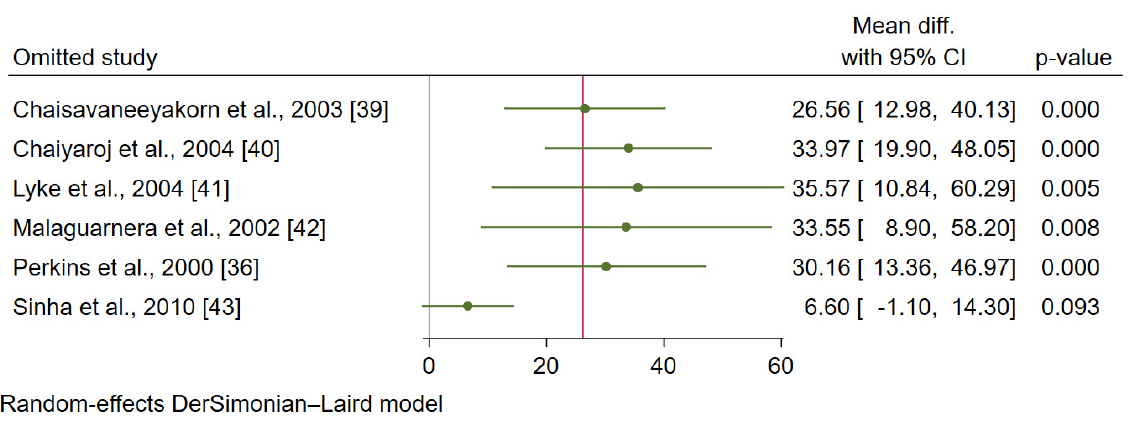
Figure 9. The results of the leave-one-out meta-analysis of the difference in the mean IL-12 levels (pg/mL) between patients with uncomplicated malaria and healthy controls [36,39–43]. (pg/mL) between patients with uncomplicated malaria and healthy controls